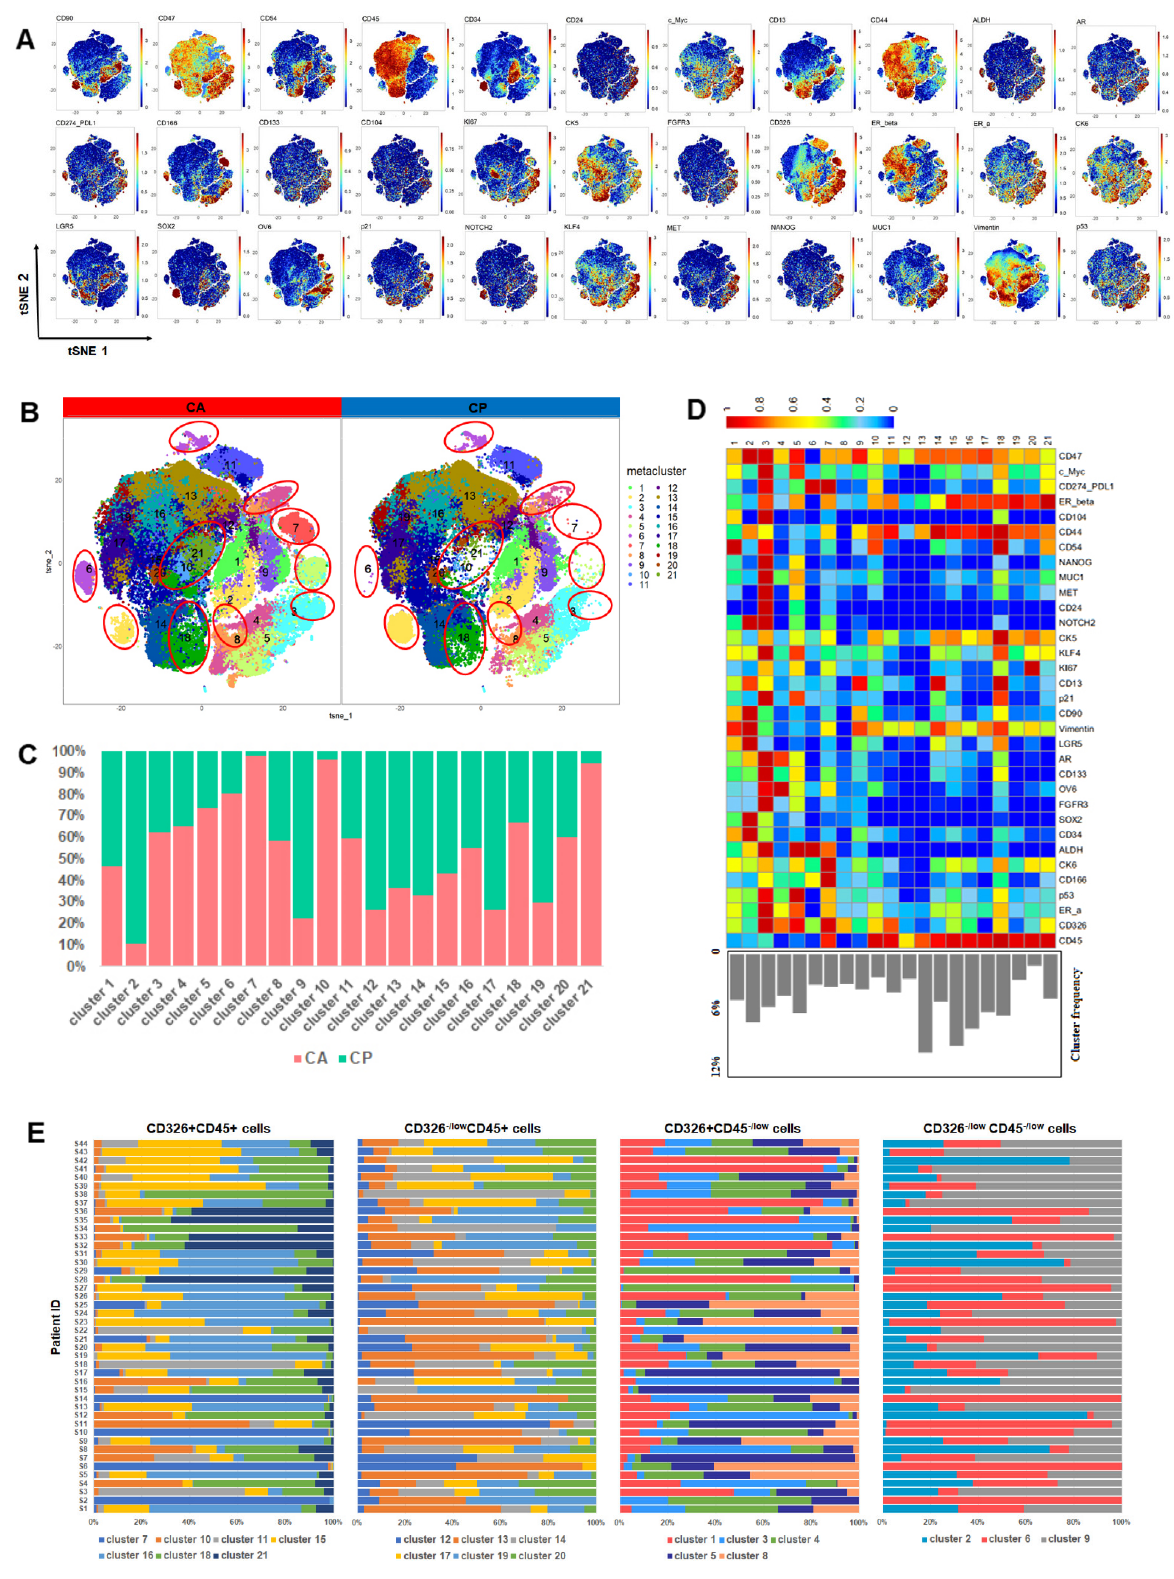
Figure 1. TME landscape in MIBC. ( A ) t-SNE plots of indicated markers of single cells from all samples. ( B ) t-SNE plots of the distinct clusters from cancer (CA) and para-carcinoma (CP) tissues. ( C ) Relative frequencies of 21 clusters in CA and CP tissues. ( D ) Heatmap of indicated markers expression of 21 clusters. ( E ) Relative frequencies of 21 clusters in individual